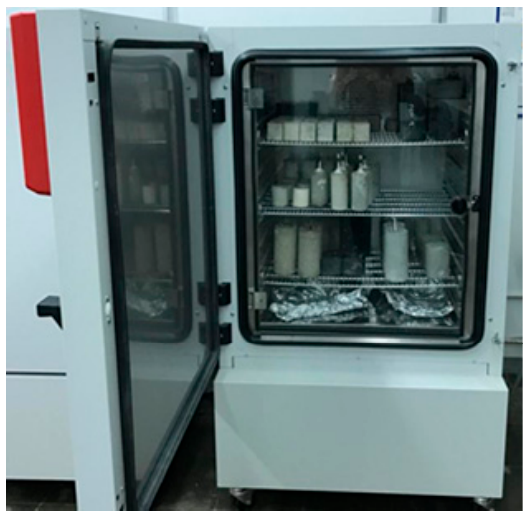
Figure 12. Climate chamber for the CO 2 exposure under the controlled conditions.